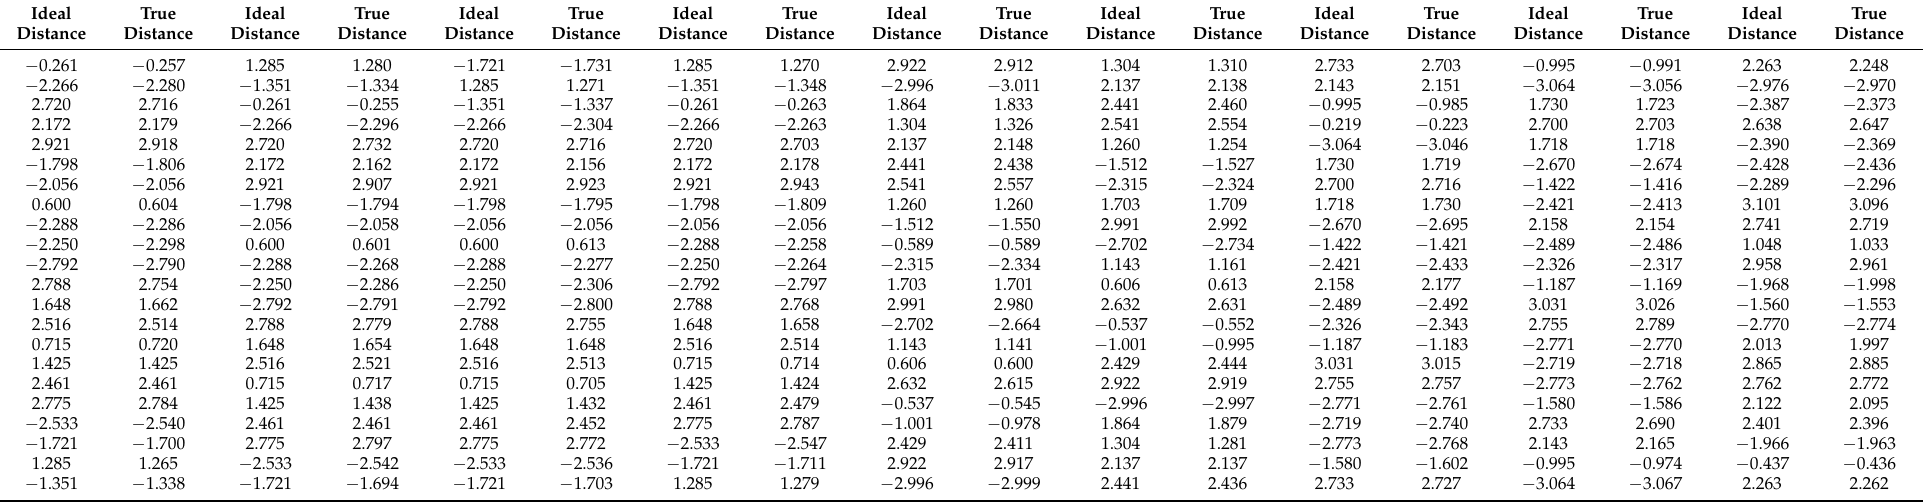
Table A3. Expected rotation angles and actual rotation angles